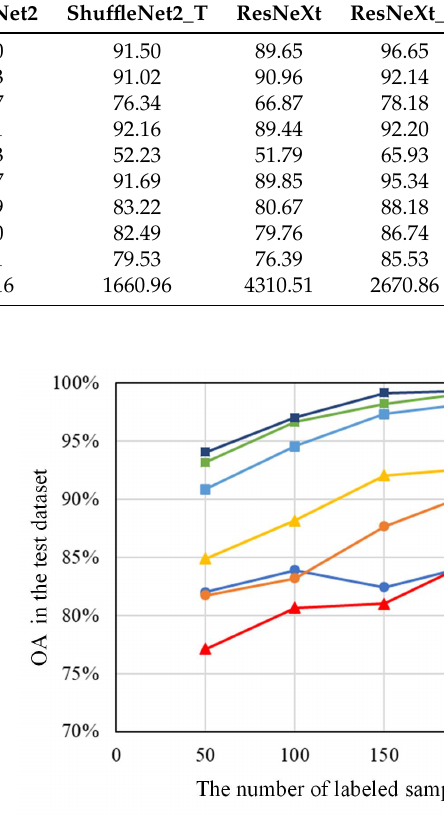
Figure 15. Overall classification accuracies of the test samples based on various methods trained/fine- tuned with 50–250 labeled samples for the DC Mall